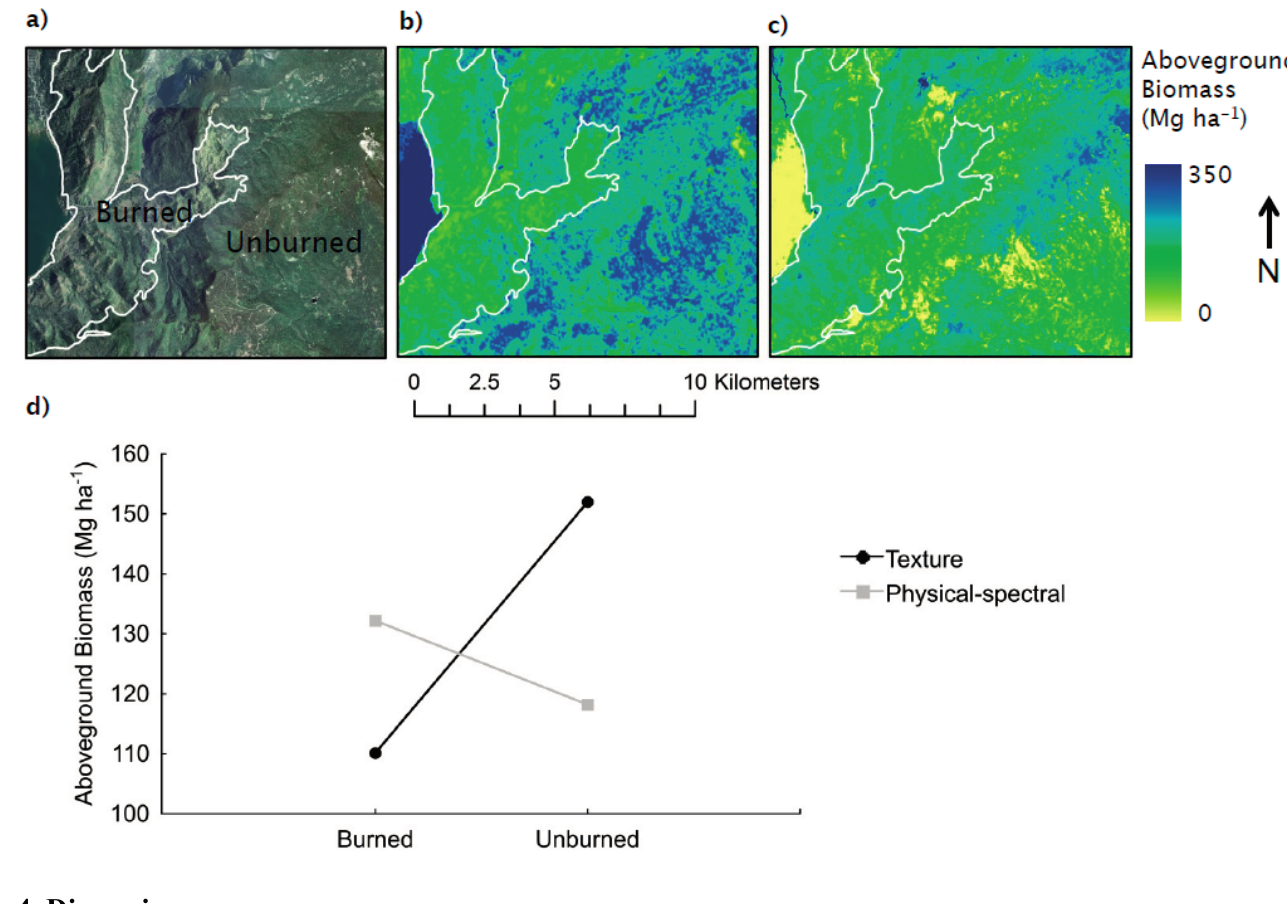
Figure 5. ( a ) True color image from National Agricultural Imagery Program, acquired by a Leica ADS80 Airborne Digital Sensor; ( b ) image texture-based biomass map; and ( c ) physical-spectral (slope, aspect, elevation, Normalized Difference Vegetation Index) based biomass map for a region of San Juan National Forest burned by a wildfire in 2002. Color bar and scale bar apply to (a), (b), and (c); ( d ) Modeled stand-average biomass of the burned region was compared to the unburned region to the East of the